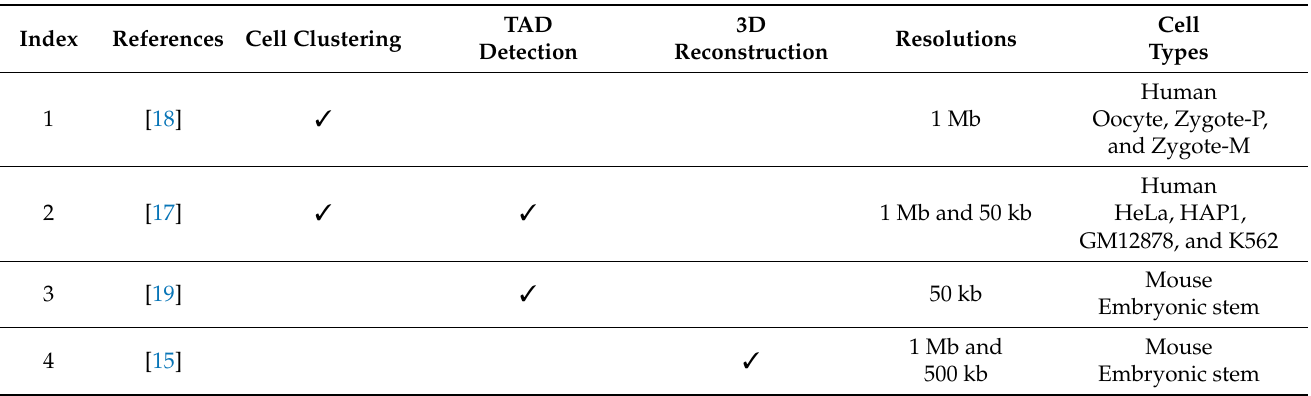
Table 1. Single-cell Hi-C data sets used in scHiCEmbed for the three main tasks, including cell type clustering, TAD detection, and 3D genome reconstruction at different